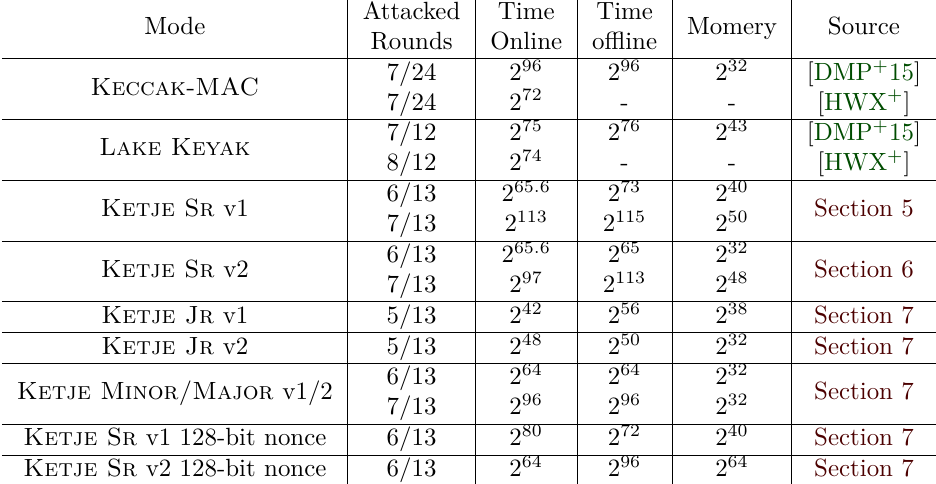
Table 1: Summary of Key-recovery Attacks on Ketje , Keyak and Keccak-MAC